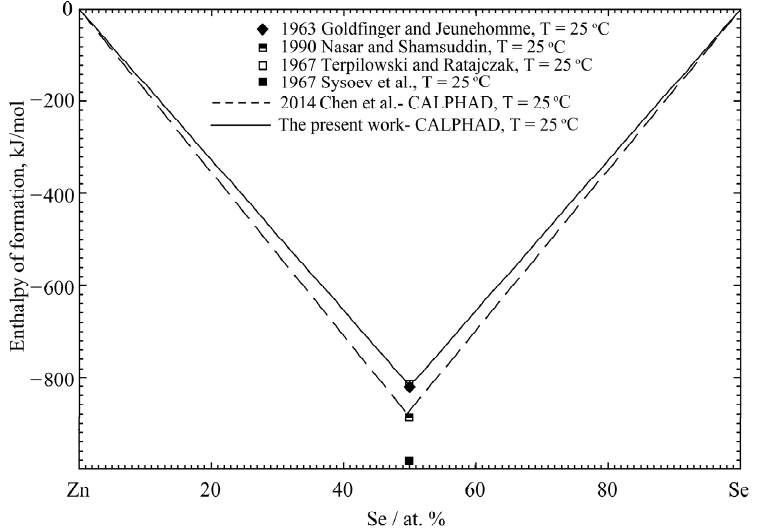
Figure 16. The calculated standard enthalpy of formation at 25 °C in the Zn-Se system compared with the experimental data from refs. [106,118,123,133] and previously optimized results by Chen et al. [125].